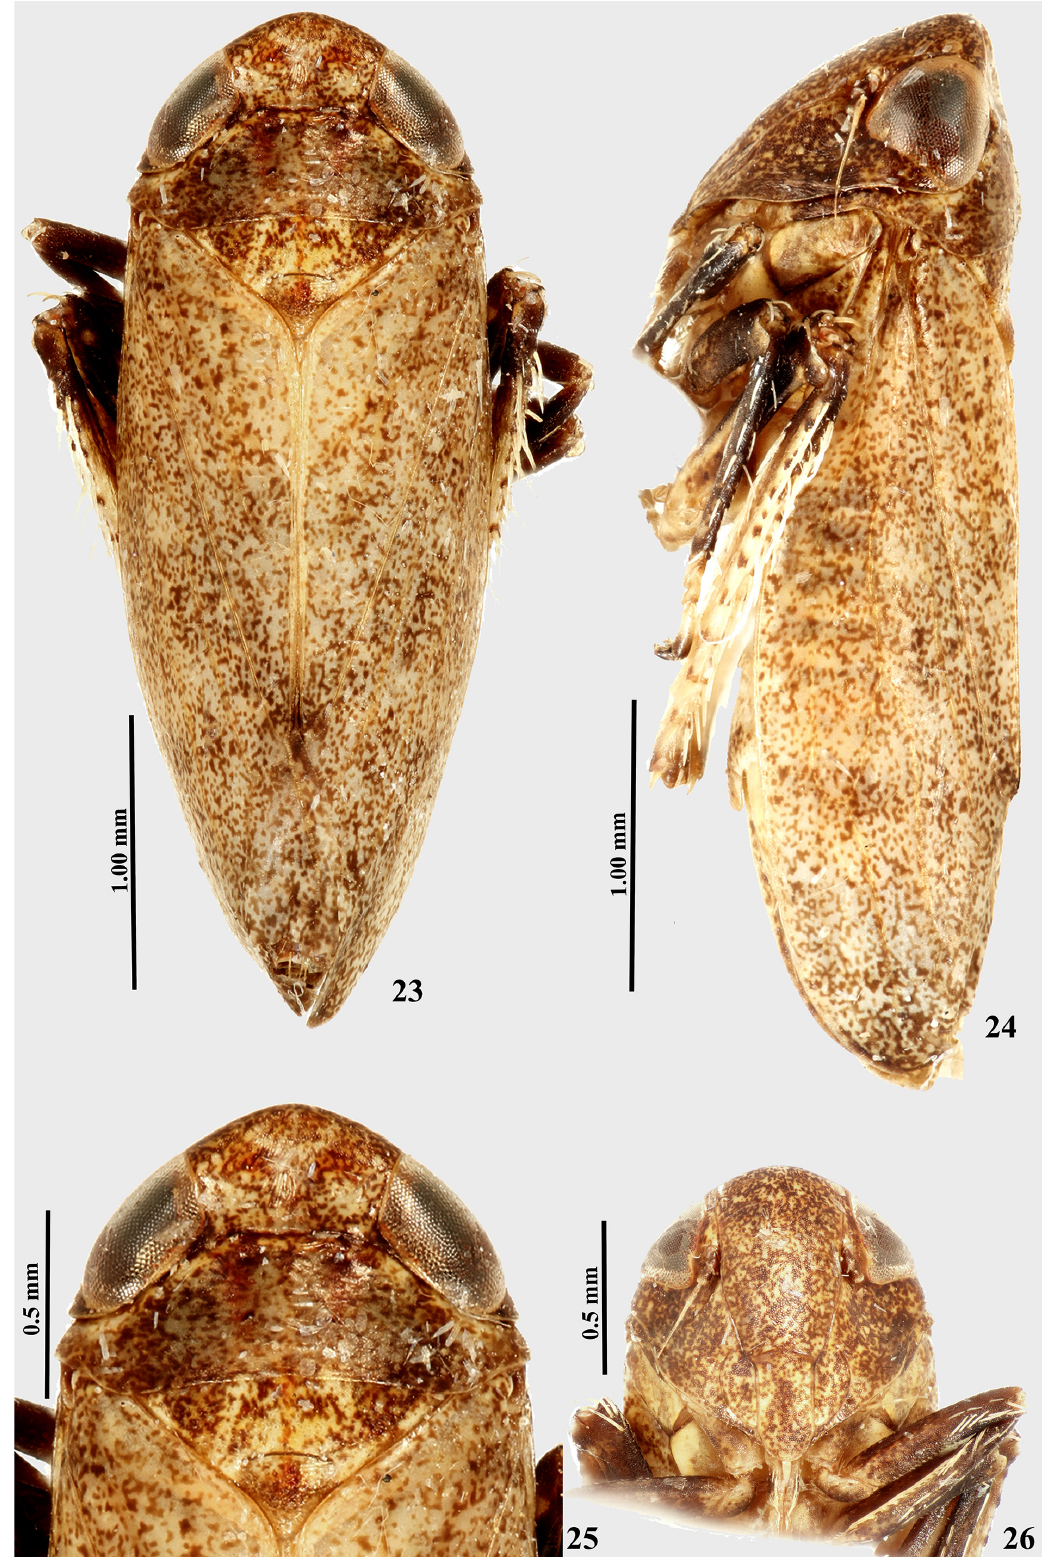
Figs 23−26. Oshaibahus kadiae El-Sonbati & Wilson gen. et sp. nov. 23 . Dorsal view. 24 . Lateral view. 25 . Dorsal view of head and thorax. 26 .